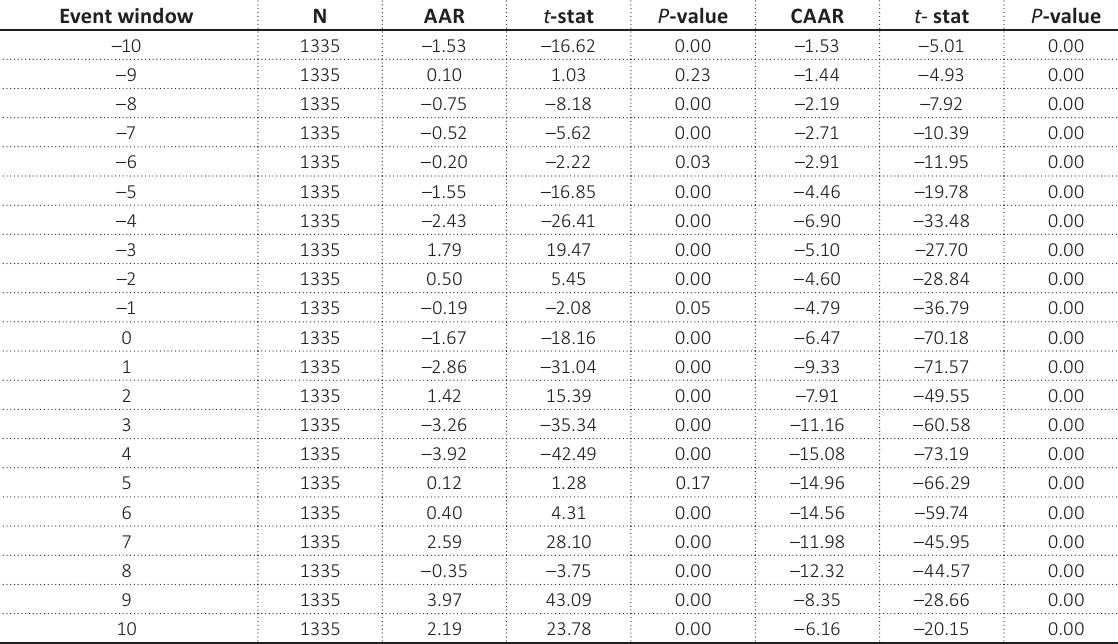
Table 2. Day-wise AAR and CAAR for the NSE-listed firms to show the impact of the COVID-19 outbreak Event